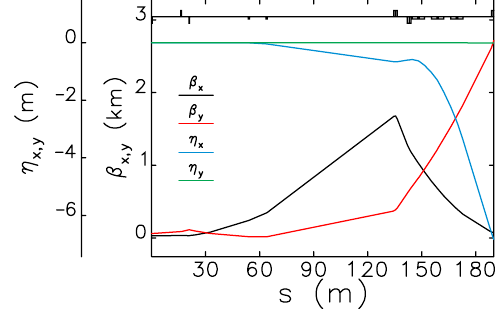
FIG. 5. A-line optics (beta and dispersion) functions from the end of the LCLS linac.